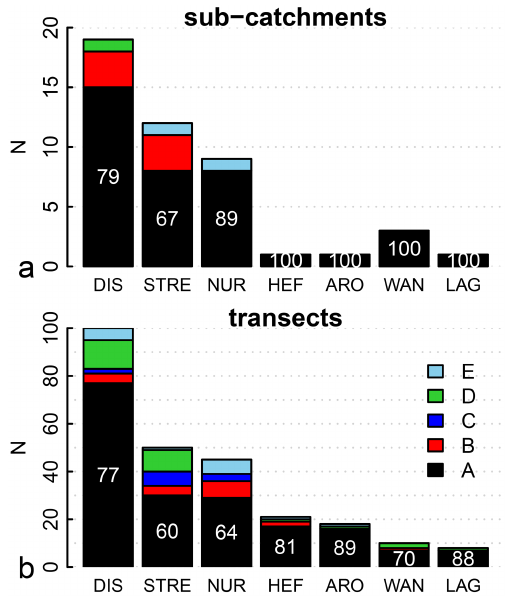
Figure 8. Frequency distribution of the types of gradients (A–B as shown in Fig. 4) for sub-catchments (a) and transects (b) of each data set. White numbers indicate the percentage of subareas classi- fied as type